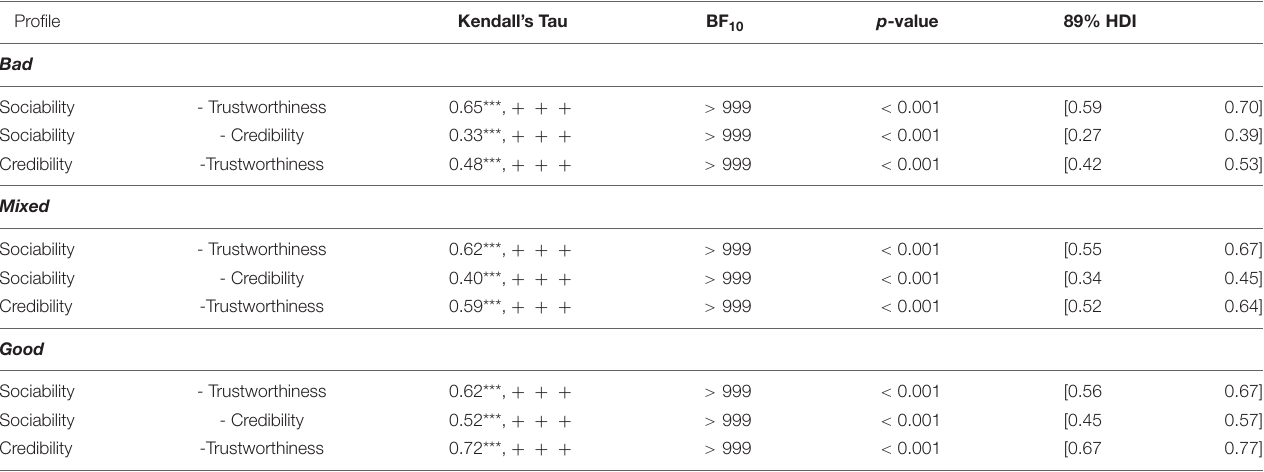
TABLE 16 | Correlations Between Perception of Hosts Measures for Each Profile